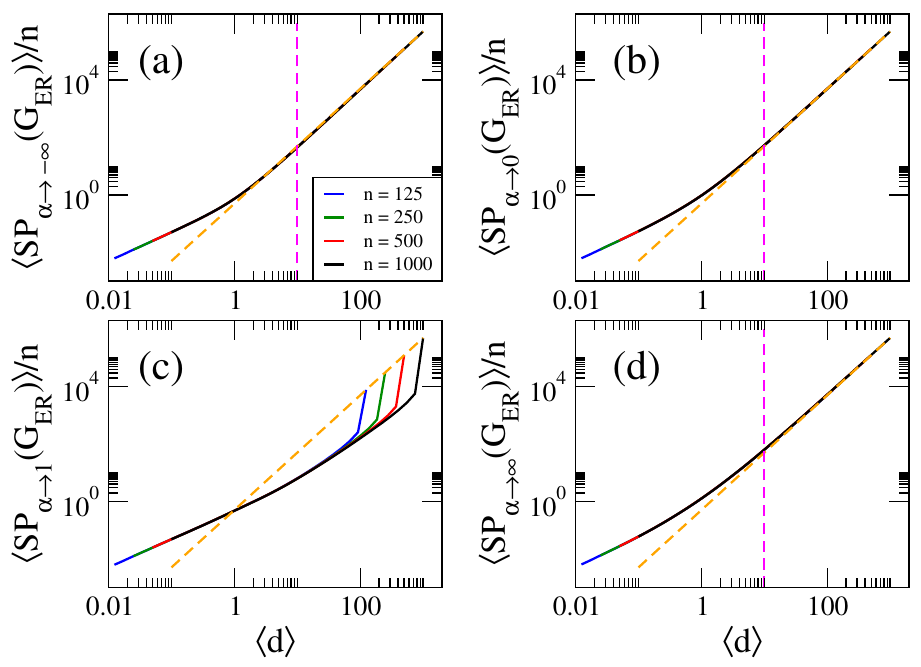
, normalized to the network size n , as a function of α ( G ER ) (cid:105)